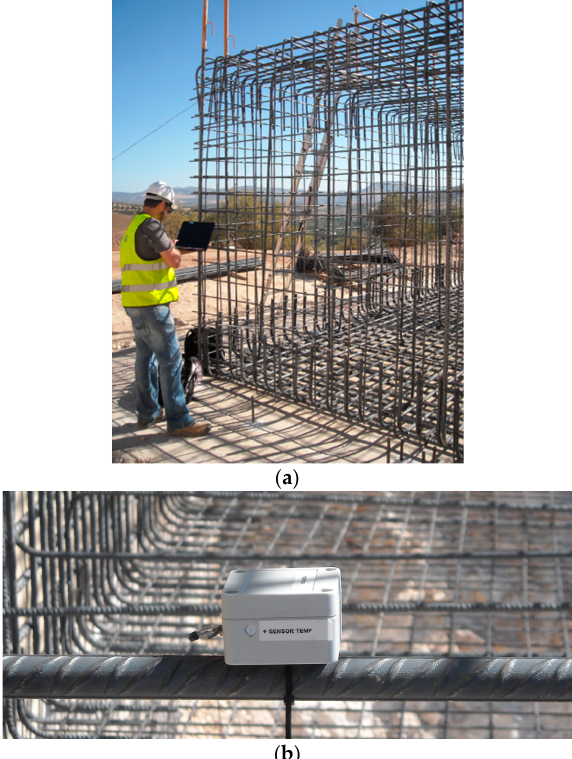
Figure 13. ( a ) Operator testing a sensor on the steel structure; ( b ) Detail of the mote tied to a steel bar.